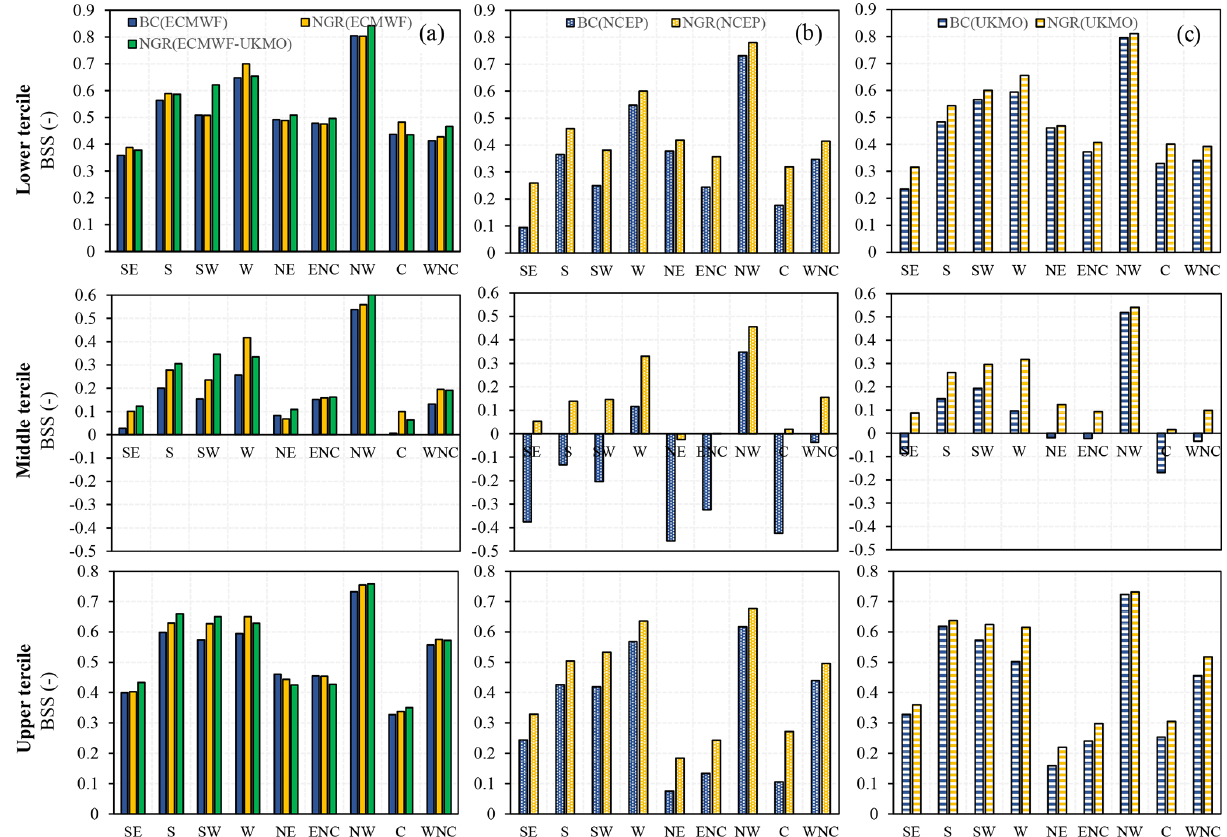
Figure 8. Comparison between BC- and NGR-based Brier skill scores considering (a) ECMWF and ECMWF–UKMO forecasts, (b) NCEP, and (c) UKMO forecasts across the different climate